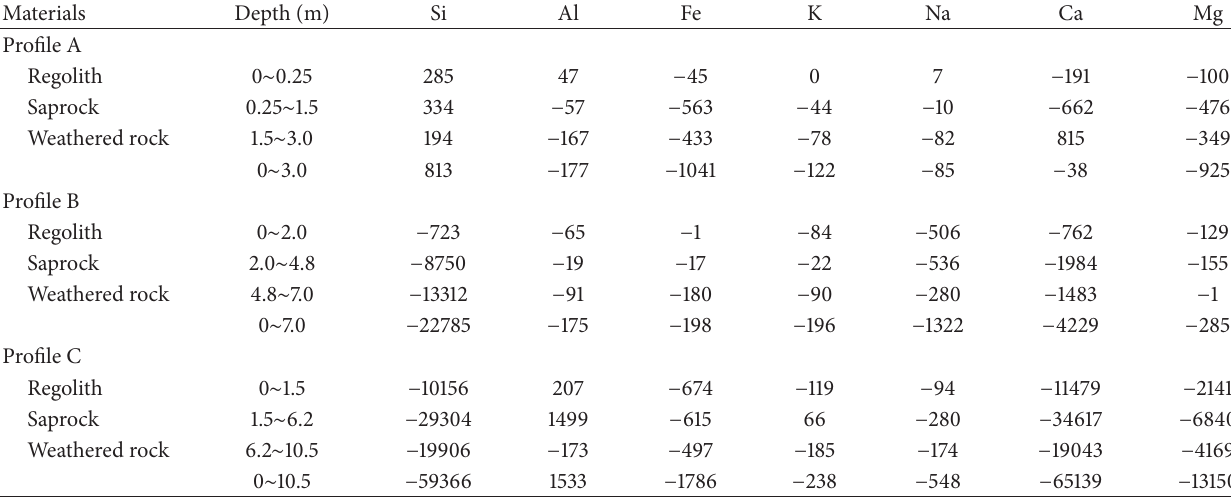
Table 4: Mass fluxes (mol/m 2 ) of major elements in three